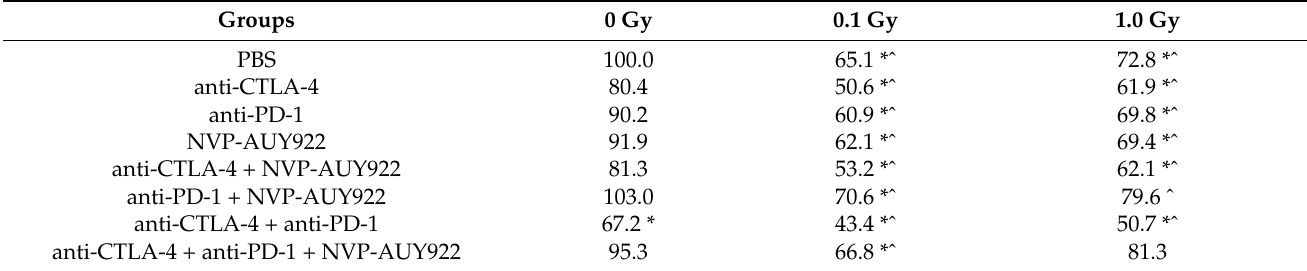
Table 1. Clonogenic capacity (CC) in vitro of tumor cells obtained from the lungs of C57BL/6 mice(intravenously) i.v. injected with LLC1 cells and treated with blockers of the immune checkpoints and/or heat shock protein 90 (HSP90) combined with whole-body irradiations (WBI) at total doses of 0.1 and 1.0 Gy. Results are expressed as percentages of the control value